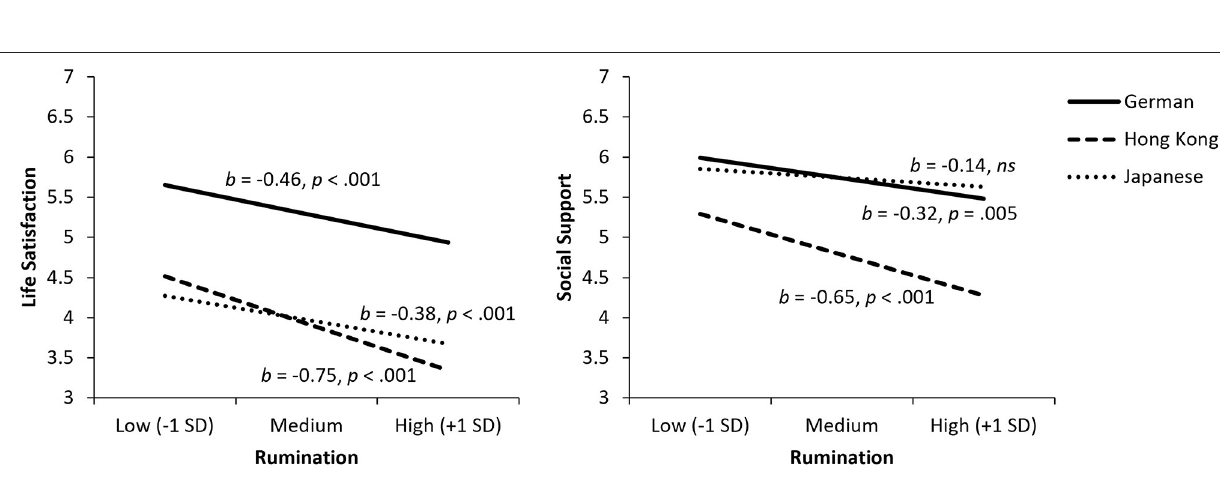
Frontiers in Psychology |